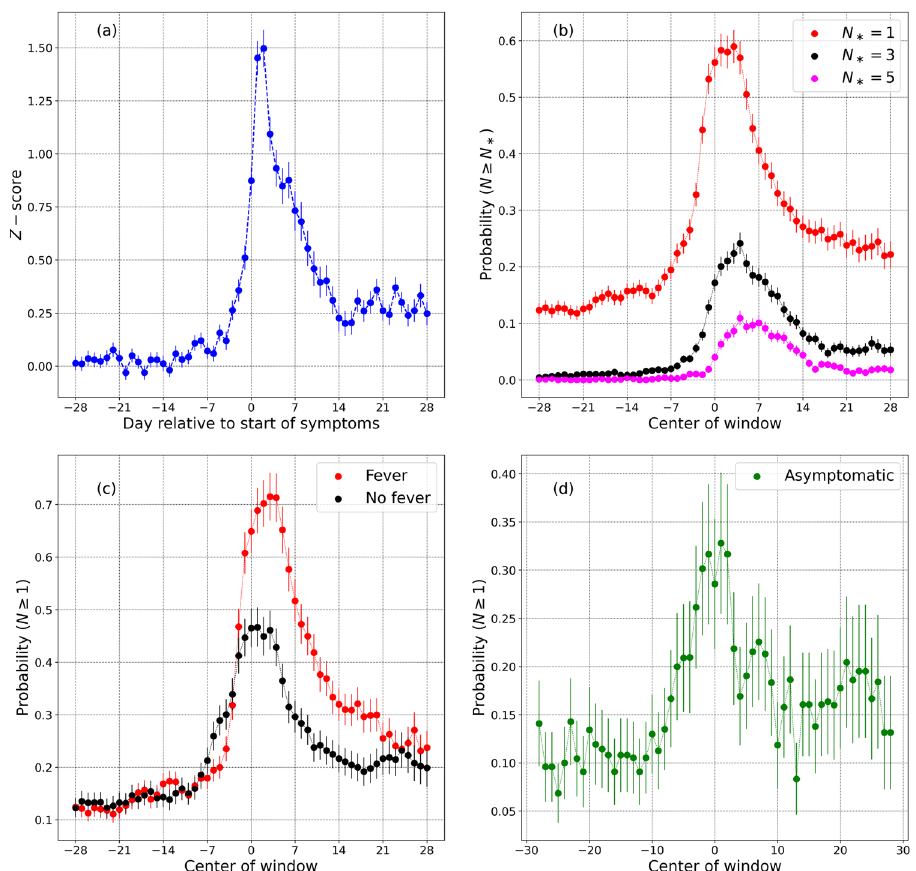
Fig. 4 Impact of COVID-19 on respiratory rate. a This shows the dimensionless z- scored respiratory rate in symptomatic individuals, with day relative to the start of symptoms (Day 0 is the day when symptoms present). b Measures the probability of receiving N ≥ N * anomalously high values in a 7 day window centered on day D , for N * = 1, 3, 5. The effect of fever is seen in c . The variation of respiratory rate for asymptomatic individuals is shown in d . Error bars show the standard error of the